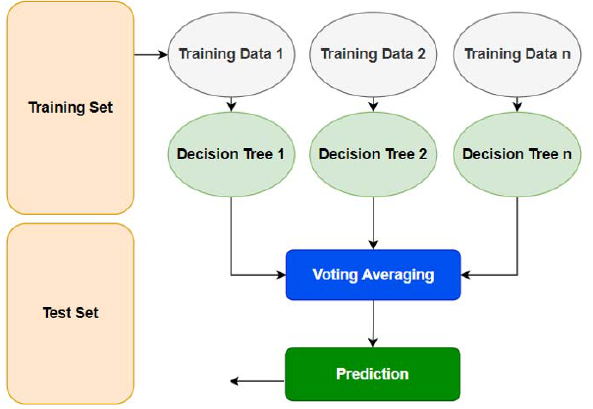
Figure 8. Random forest algorithm for decision tree simplification.